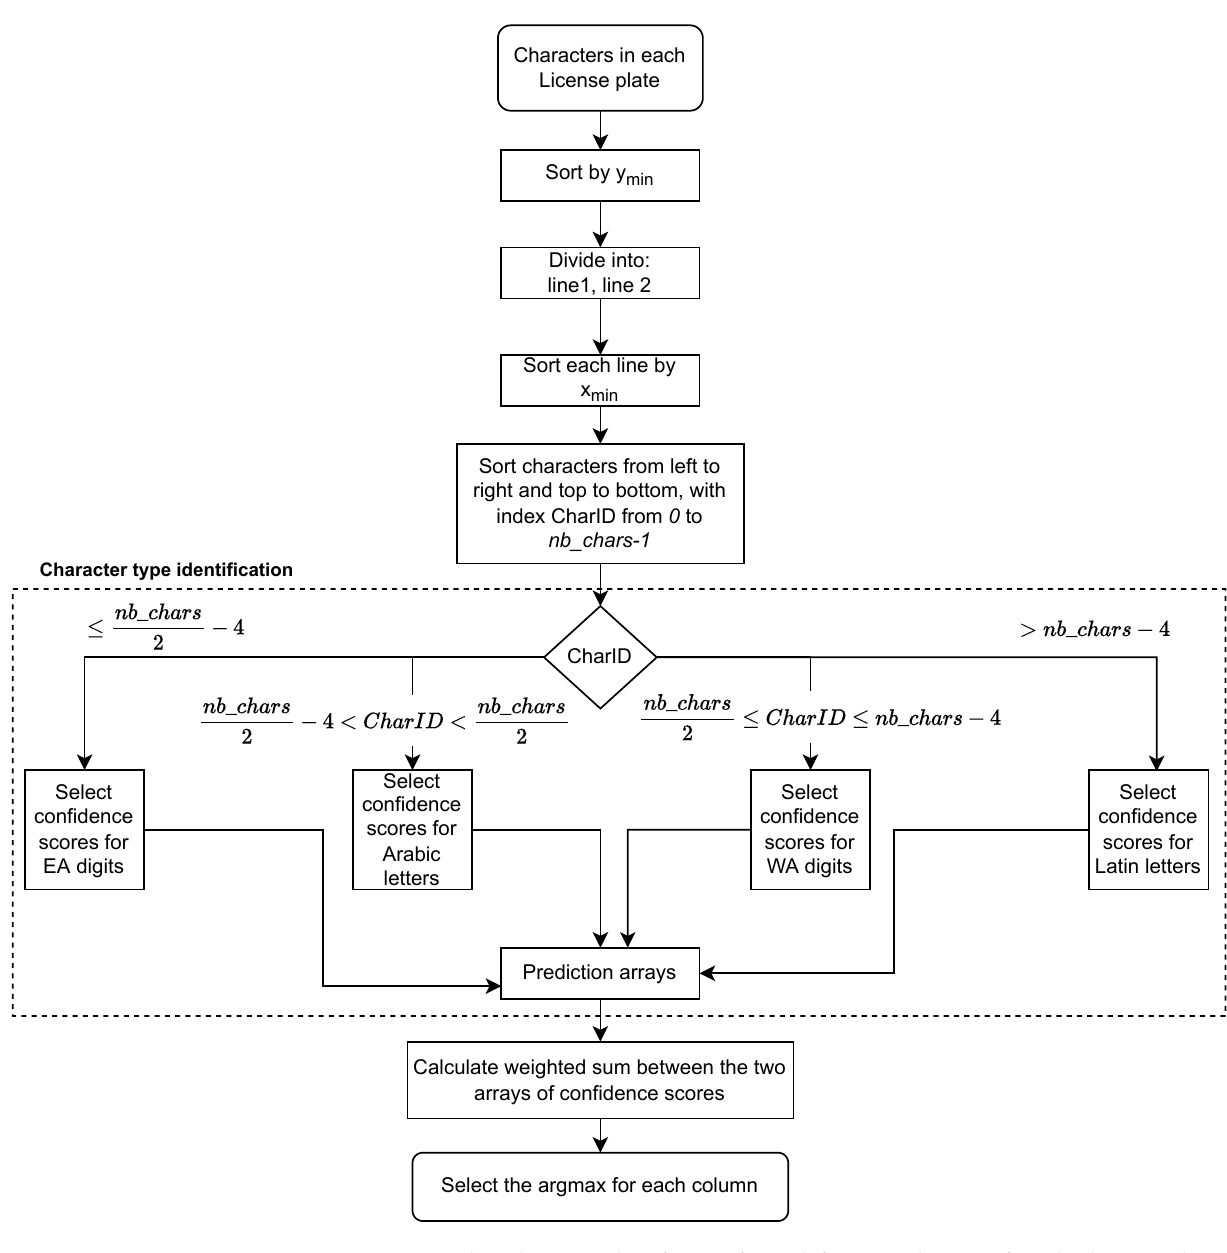
Figure 7. License plate character identification for each frame, in the case of single-character detection. EA stands for Eastern Arabic, while WA stands for Western